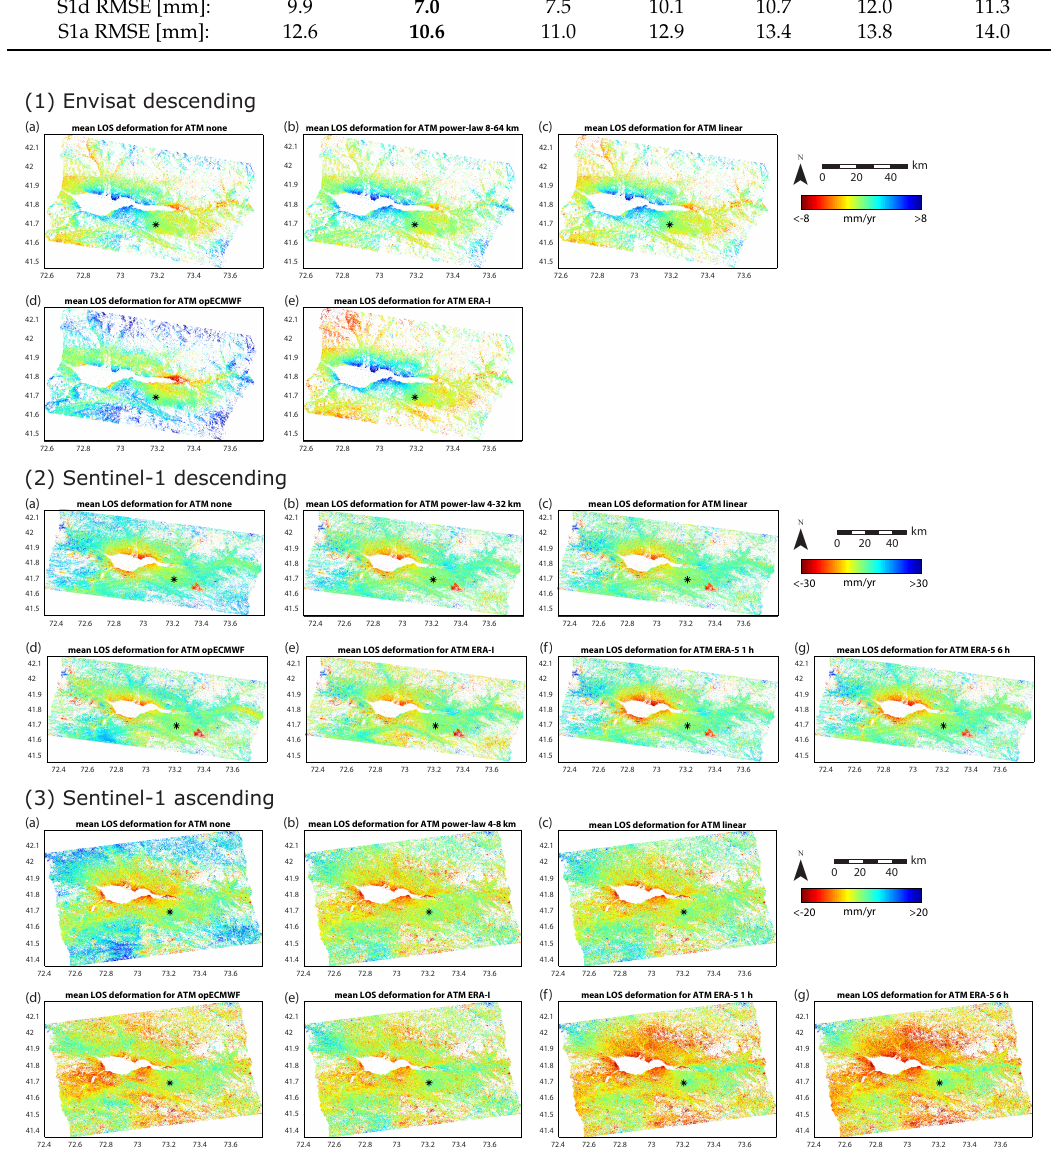
Figure 4. Mean line-of-sight (LOS) deformation values for various atmospheric corrections of the ( 1 ) Envisat descending; ( 2 ) Sentinel-1 descending and ( 3 ) Sentinel-1 ascending time series. ( a ) no atmospheric correction applied; ( b ) best results of the power-law technique; ( c ) linear dependency on the topography; ( d ) correction with the operational weather model (opECMWF) analysis; ( e ) ERA-I weather model correction; ( f ) the ERA-5 1h temporal resolution solution and ( g ) the ERA-5 6h temporal resolution solution. The black asterisks show the location of the reference